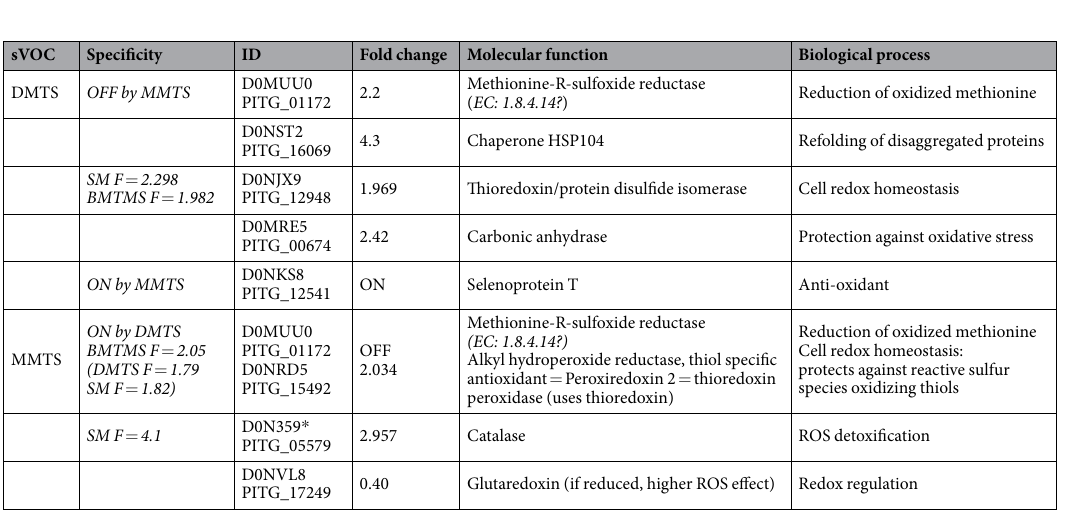
Table 3. Proteins regulated by DMTS or MMTS with putative function in response to oxidative stress. * Or D0N358 (PITG_05578) not clearly